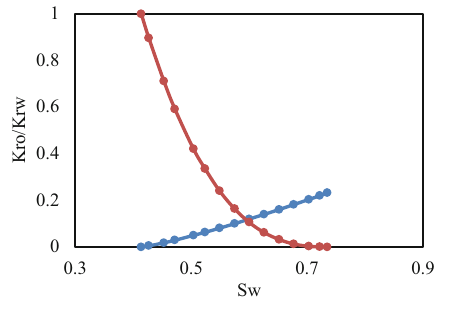
Fig. 2 Permeability model for injecting into thick layers and producing from thin ones